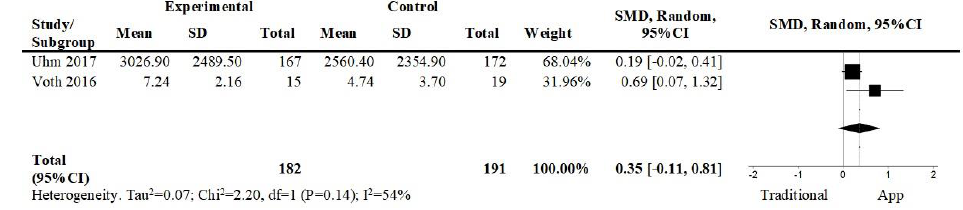
Figure 5. Forest plot of comparison. App vs. Traditional, short term, outcome: self-reported physical activity. Abbreviations: CI, confidence interval; df, degrees of freedom; SMD, standardized mean difference.